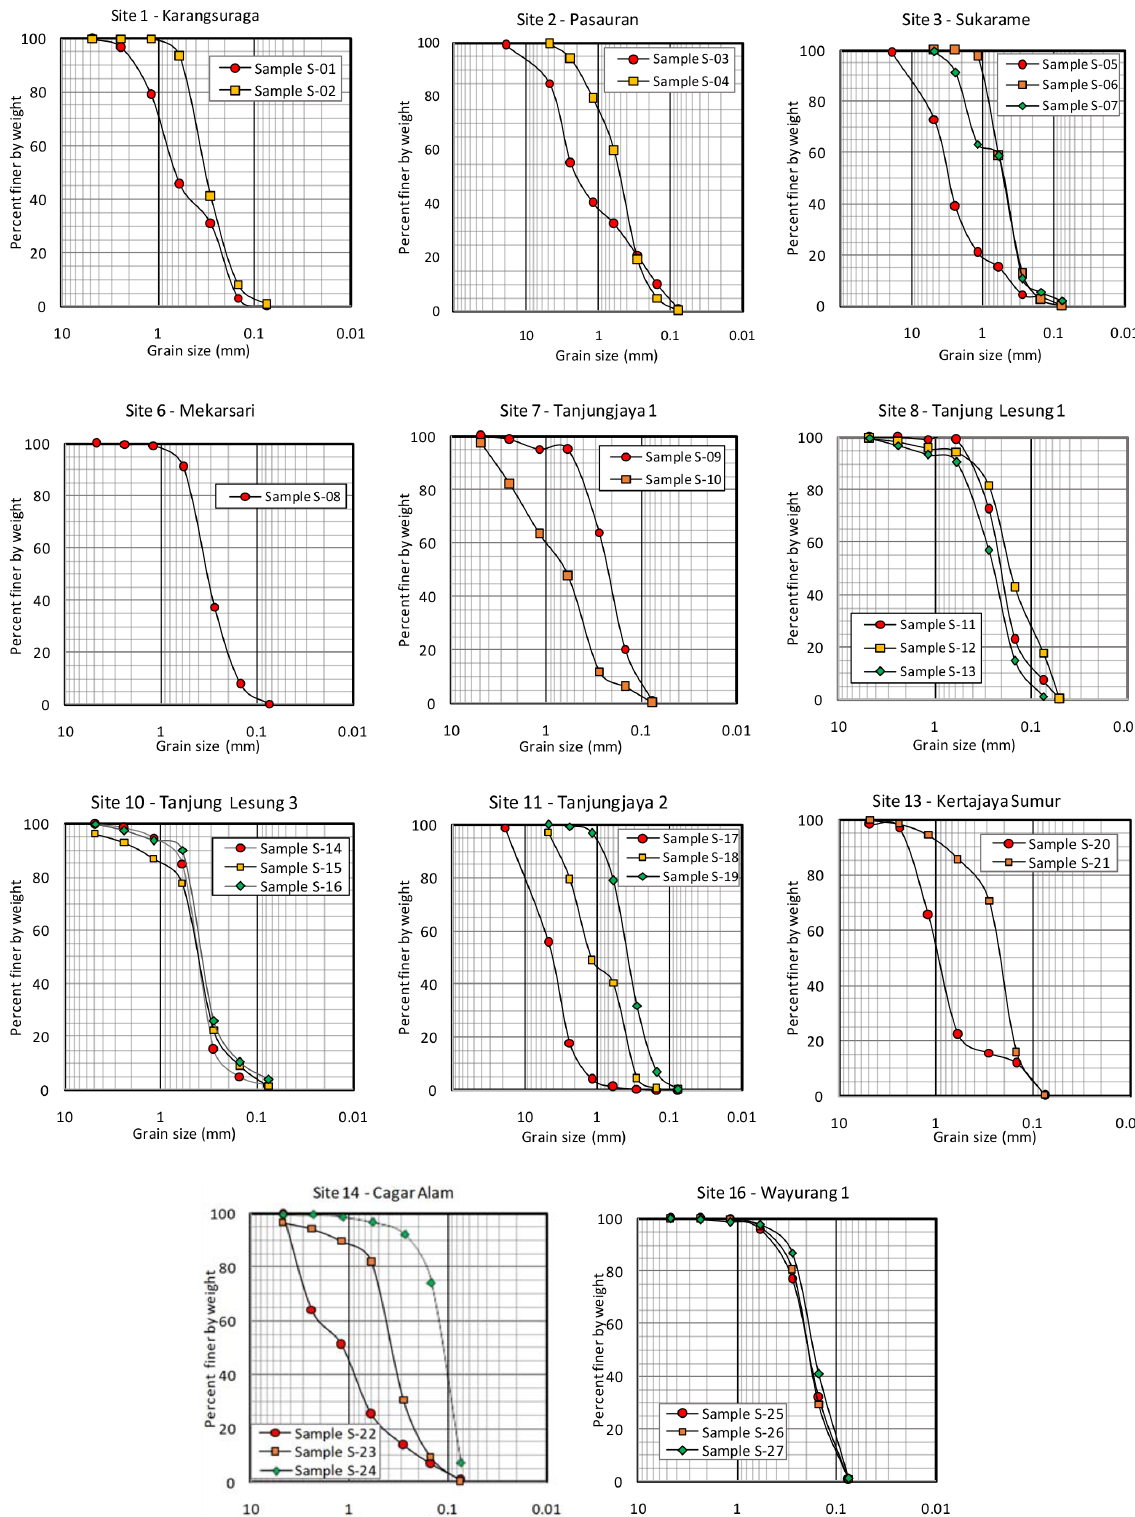
Figure 8. Sediment grain size results from sieve analysis for various